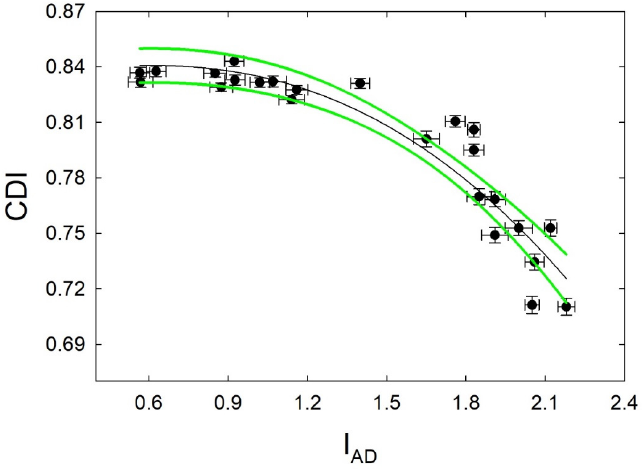
Figure 9. Polynomial regression fit (black line) describing the relationship between Colour Development Index (CDI) and Index of Absorbance Difference (I AD ) in ‘Majestic Pearl’ nectarine fruit in 2021–2022. The points represent medians of experimental units (row orientation arm) at different times form harvest ( n = 80 per experimental unit); horizontal and vertical bars show standard errors of the means; green lines show 95% confidence intervals. Model equation: CDI = 0.835 (0.004) − 0.030 (0.002) × I AD2 × ln (I AD ); p < 0.001; R 2 = 0.905; S.E. = 0.015.